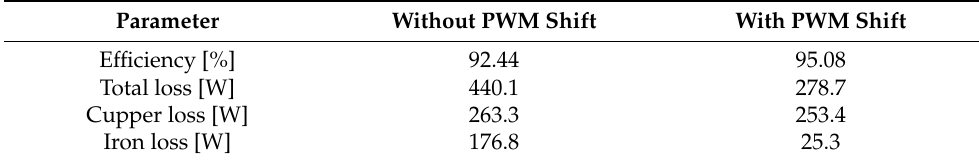
Table 2. Measured efficiency and loss, 1500 rpm 30 Arms